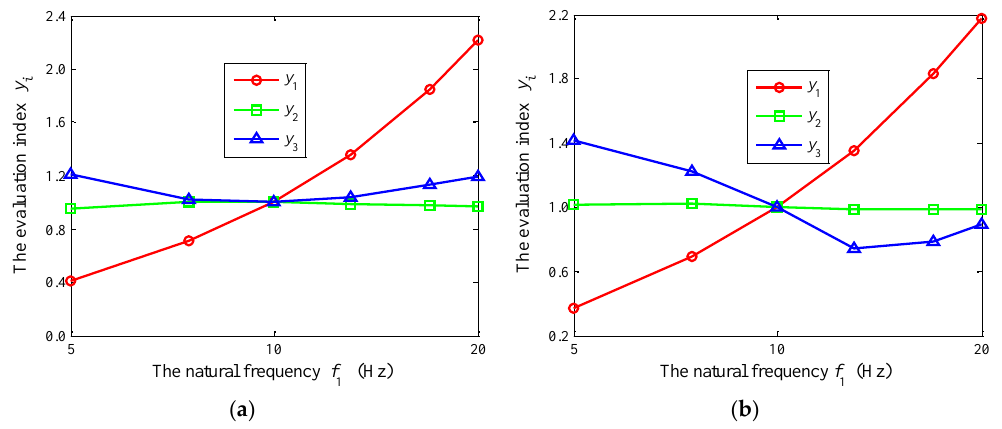
Figure 18. The evaluation index y i versus the natural frequency f 1 for the wheelchair: ( a ) going up the step; ( b ) going down the step.